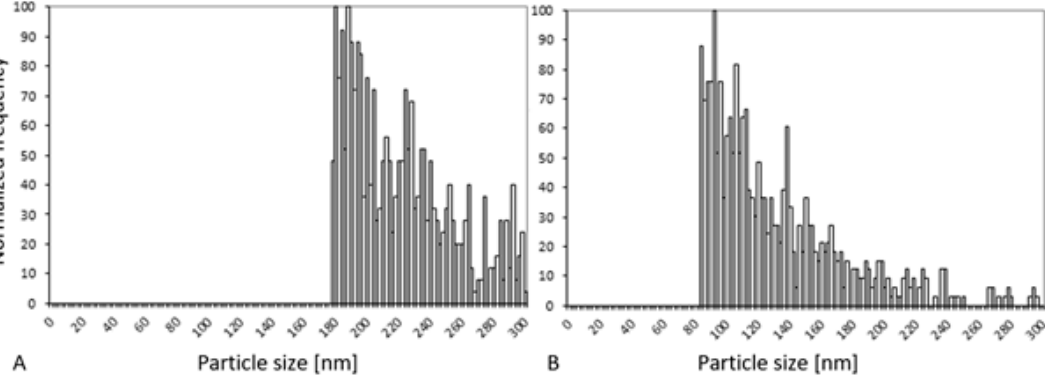
Figure 1. Particle size distribution of 400 ng mL − 1 CeO 2 NPs with ( A ) 0.5 mmol L − 1 and ( B ) 50 mmol L − 1 APAP as determined by single particle inductively coupled plasma mass spectrometry (SP-ICP-MS).